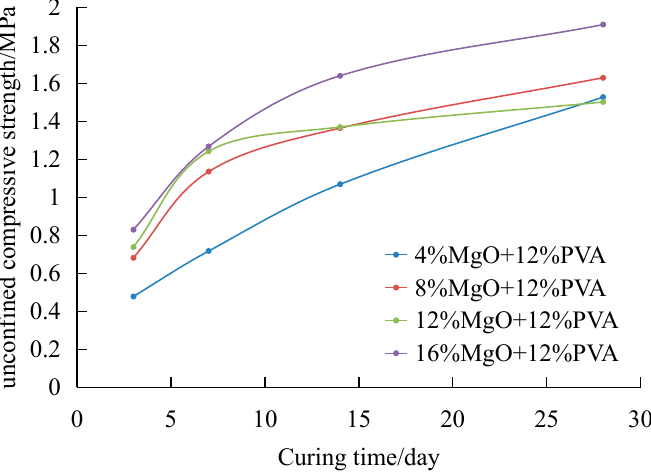
Figure 6. The change curve for UCS of composite modified samples with curing time. The curve of 12%PVA and 4% MgO shows a straight line of strength growth in the whole curing period, while the curve of other additives gradually slows down with the curing time. After 28 days, the strength of 12%PVA and 4% magnesium oxide has ex- ceeded that of 12%PVA and 12% magnesium oxide. Different from PVA modified sand whose strength has reached 90% of 28-day strength after curing for 7 days alone, the